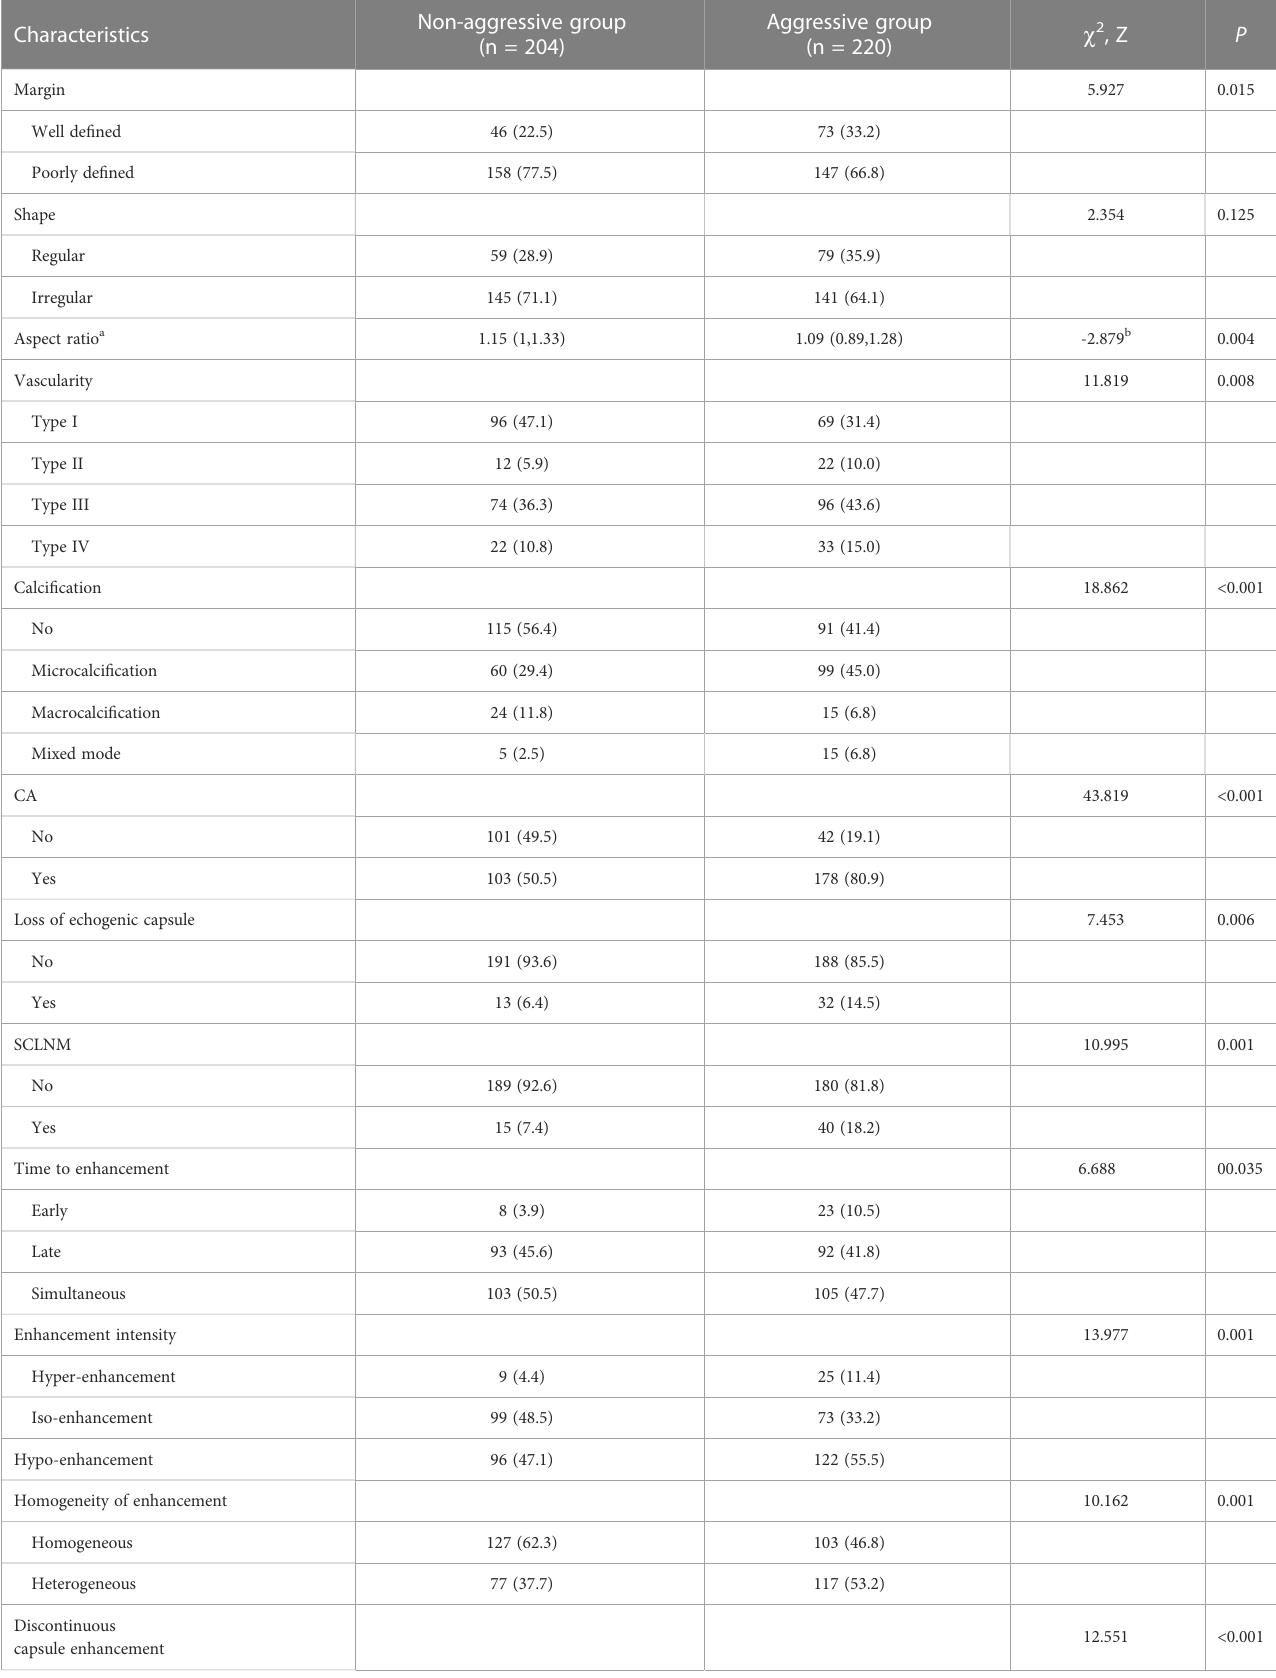
TABLE 2 Comparison of ultrasound features between the non-aggressive group and aggressive group in the primary